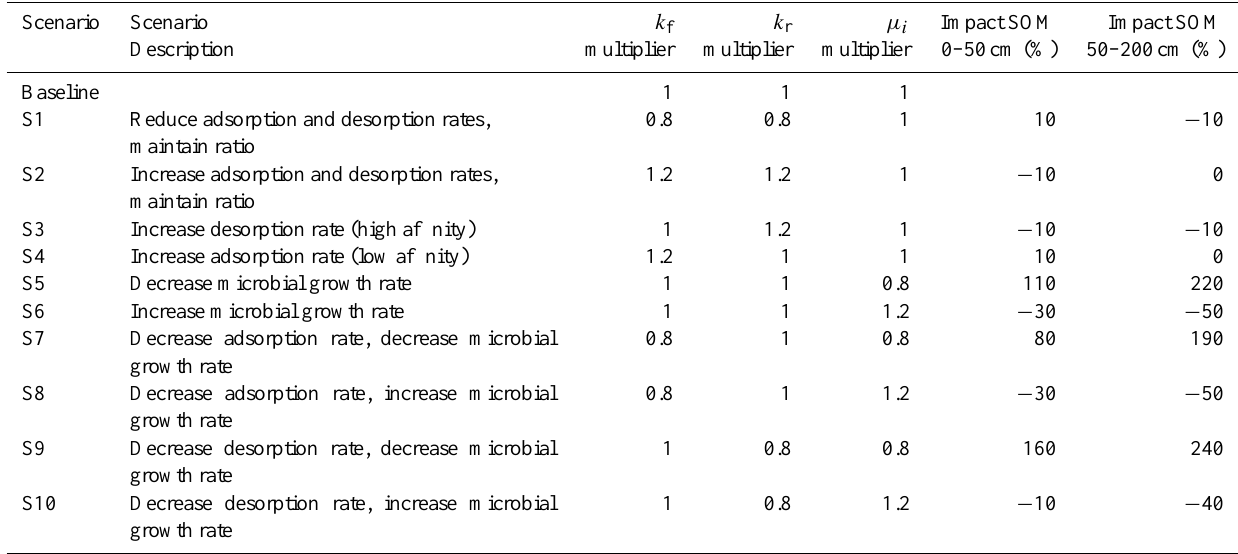
Table 3. Description of parameters and mechanisms used in the sensitivity analysis. The three multipliers indicate the factors applied to the parameter for each sensitivity scenario. The last two columns indicate the impacts of each sensitivity scenario parameter changes on 0–50cm and 50–200cm total SOM